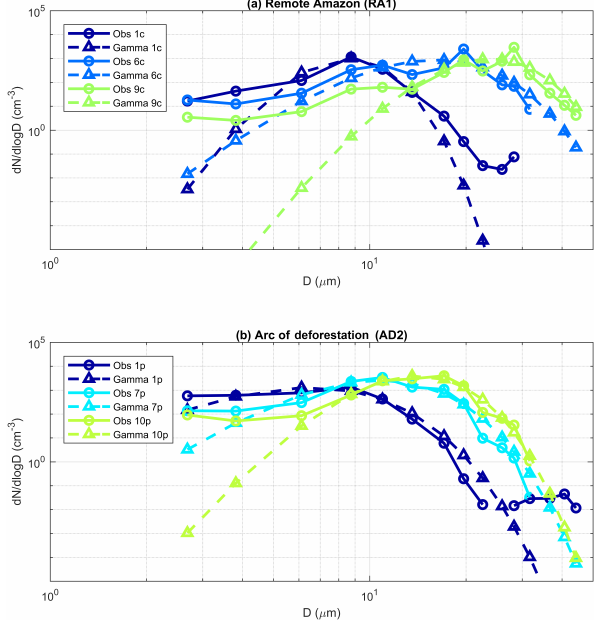
Figure 9. Averaged DSDs and their respective gamma fittings for some points in the trajectories of clouds measured over (a) the remote Amazon (flight RA1) and (b) the arc of deforestation (flight